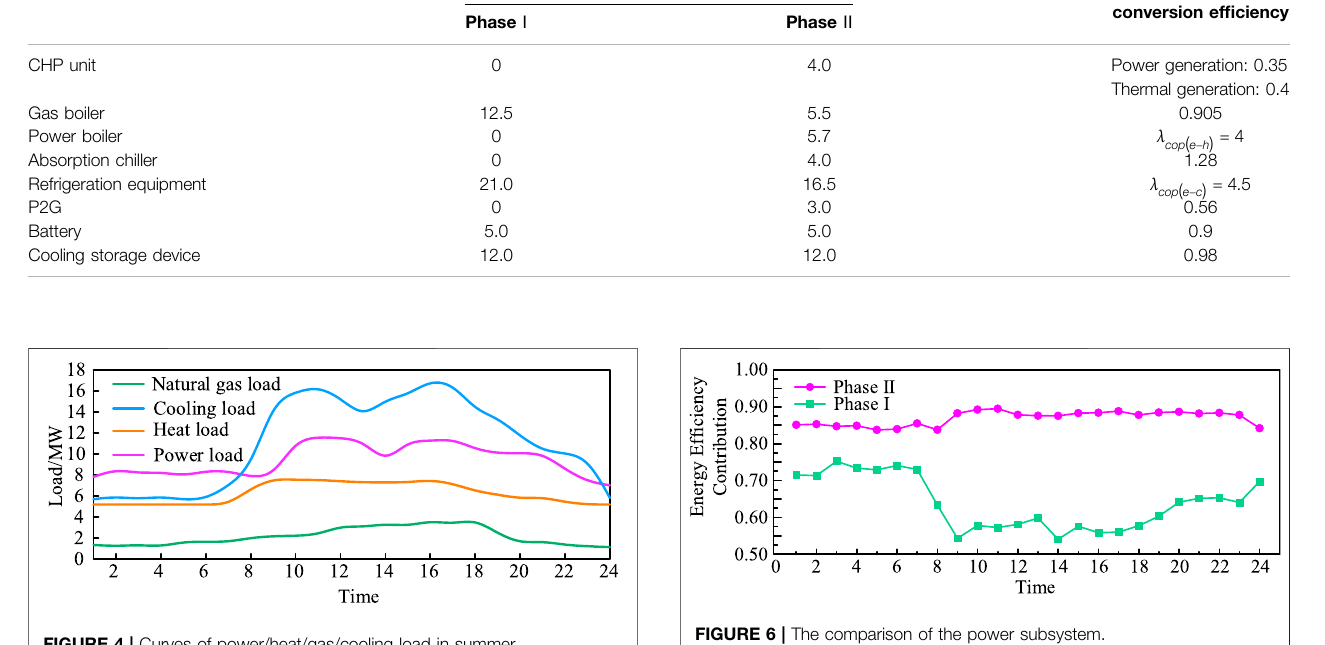
FIGURE 4 | Curves of power/heat/gas/cooling load in summer typical day.